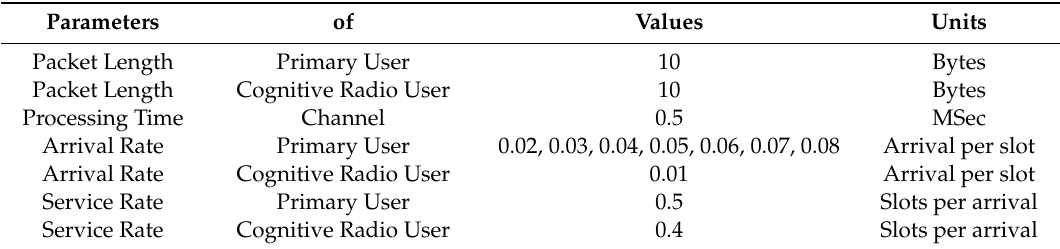
Table 2. Experimental settings: parameters with their values and